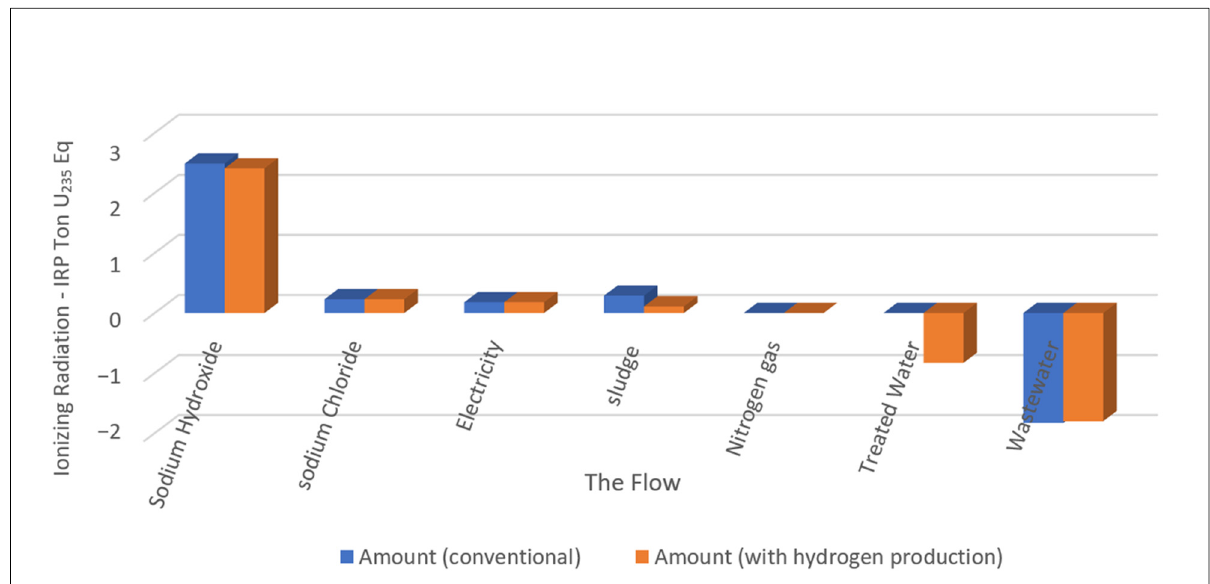
Figure 9. Main sources of ionizing radiation.